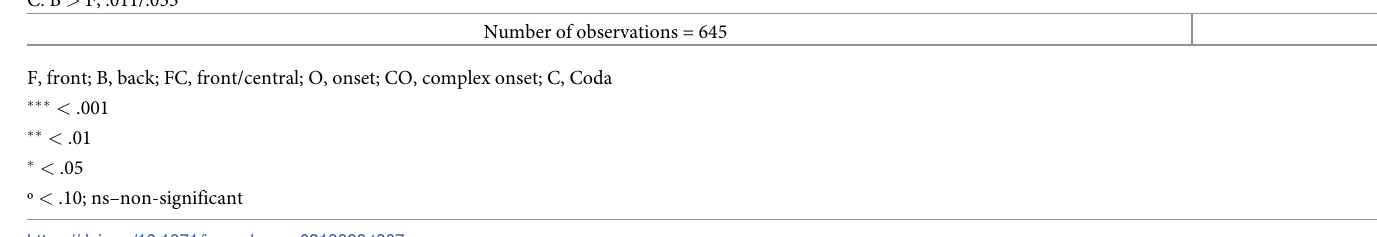
Table 8. Descriptive statistics for mean slope of F